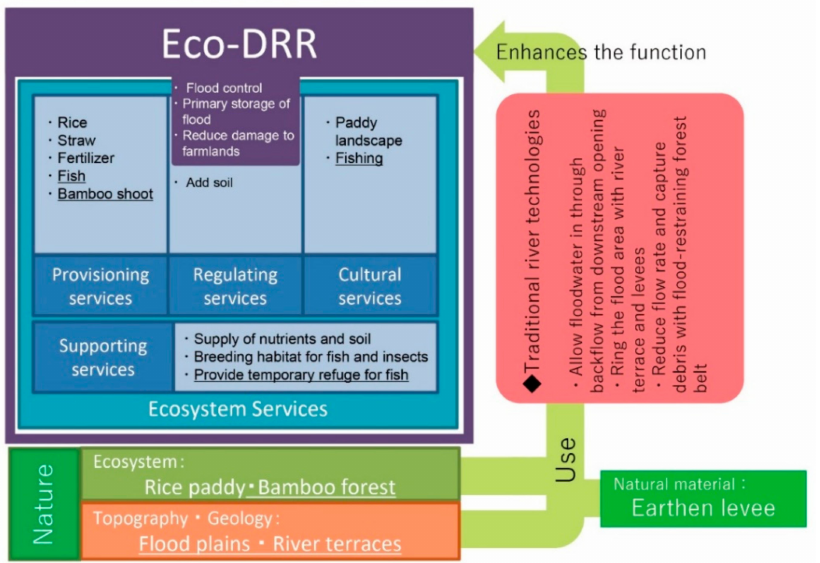
Figure 15. Eco-DRR and traditional river technology at Okawano flood plain.